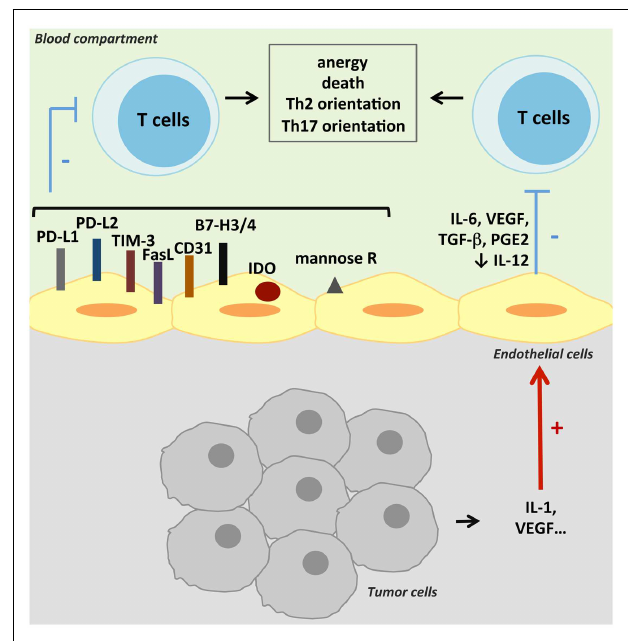
FIGURE 2 | Suppression of anti-tumoralT-cell activity .TECs can suppress anti-tumoral adaptive immunity by inducingT-cell anergy or death. This suppression can result either from a cell contact negative signal as TECs can express co-inhibitory molecules, or from inhibitory cytokines secreted byTECs.Various other mechanisms can lead toT-cell activity inhibition, like antigen presentation by the mannose receptor (mannose R) or the expression of